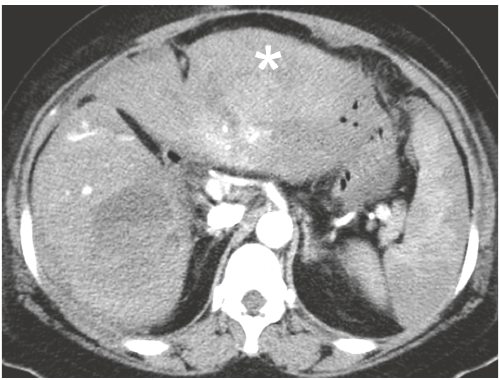
Figure 3: The computed tomographic angiography of abdomen 3 months later showed complete resolution of subscapular hematoma (asterisk). A residual hematoma over right lobe of liver was noted but without any clinical